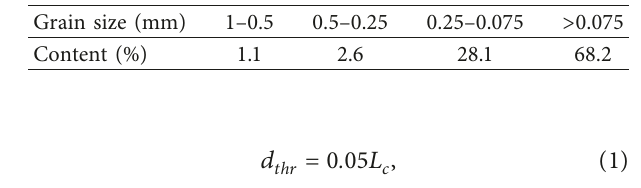
Figure 2: Medium-scale triaxial shearing instrument system: ① medium-scale triaxial chamber; ② system of axis force applied; ③ system of confining pressure applied; ④ system of volume change measured; ⑤ system of electric control; ⑥ system of data collection with a computer. Table 1: Gradation of the soil